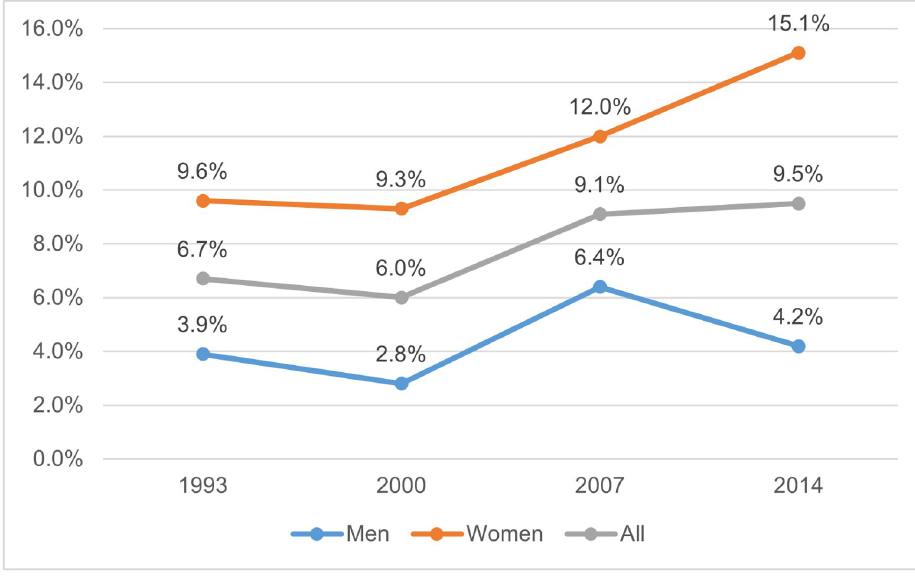
Fig 1. Prevalence of CIS-R scores of 18 or above among 16- to 24-year-olds between 1993 and